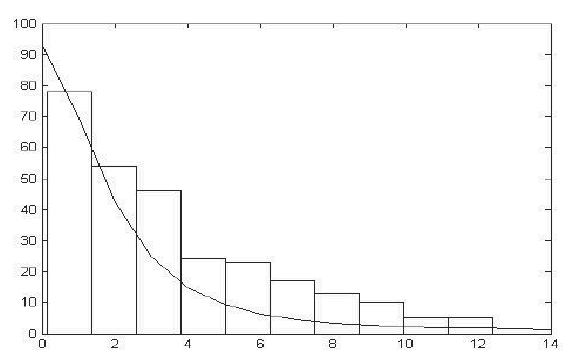
Figure 4 – The histogram of real data and the frequency curve of Mittag-Leffler distribution.